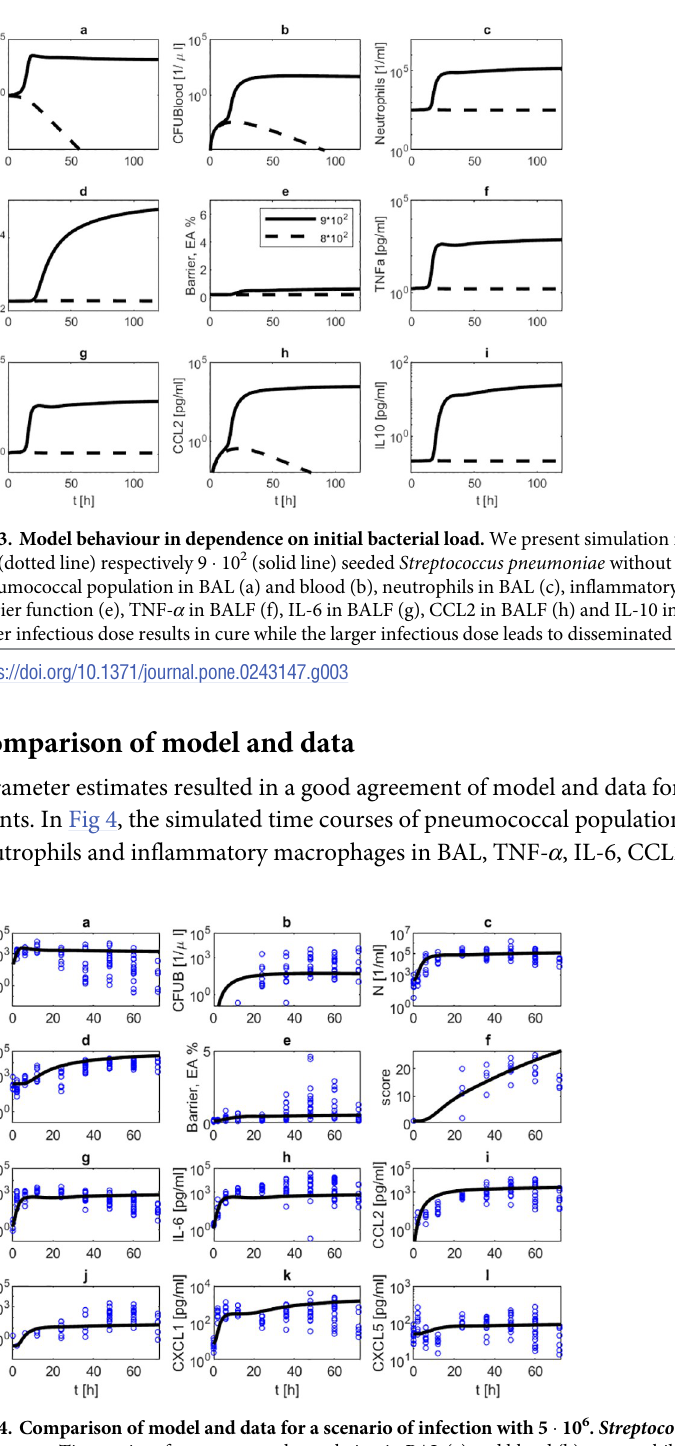
Fig 4. Comparison of model and data for a scenario of infection with 5 � 10 6 . Streptococcus pneumoniae without treatment. Time series of pneumococcal population in BAL (a) and blood (b), neutrophils in BAL (c), inflammatory macrophages in BAL (d), barrier function (e), histologic score (f), TNF- α in BALF (g), IL-6 in BALF (h), CCL2 in BALF (i), IL-10 in BALF (j), CXCL1 in BALF (k) and CXCL5 in BALF (l) without antibiotic treatment are displayed. The solid black curve represents simulation results. Circles represent data points. In this scenario, the immune system is not able to remove the infection resulting in increasing numbers of immune cells, pro-inflammatory cytokines, barrier failure and